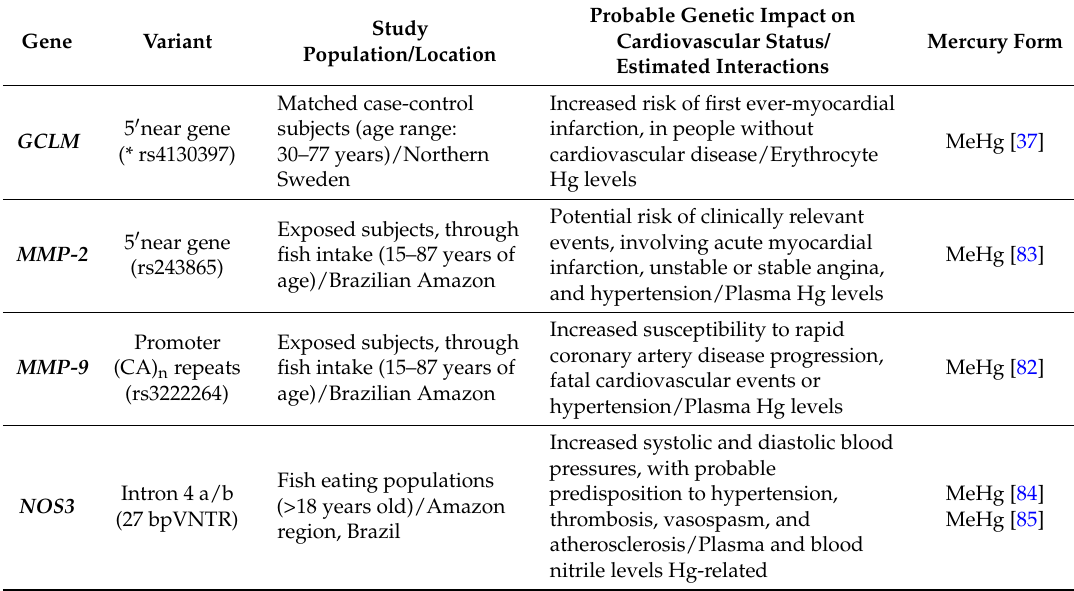
Table 4. Genetic polymorphisms modulating the human susceptibility to mercury-induced cardiovascular